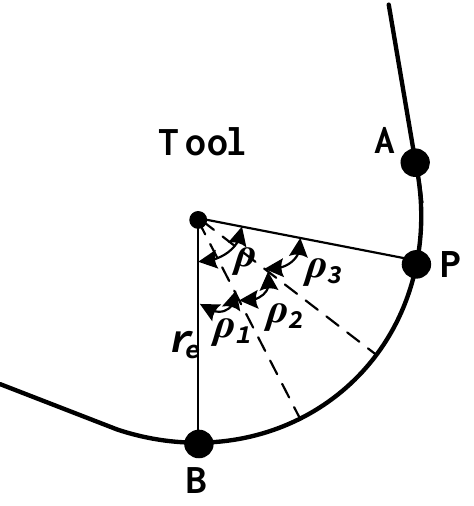
Figure 11. The schematic diagram of cutter tooth segmentation.